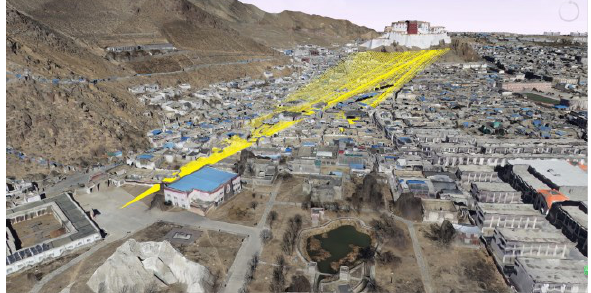
Figure 3. Corridors Calculation